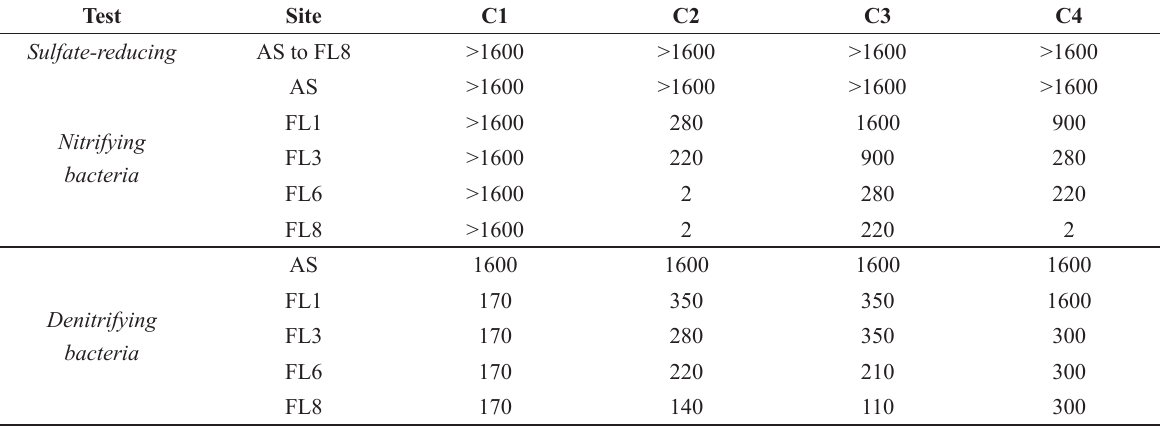
Quantification of sulfate-reducing, nitrifying, and denitrifying bacteria collected from active sludge and facultative